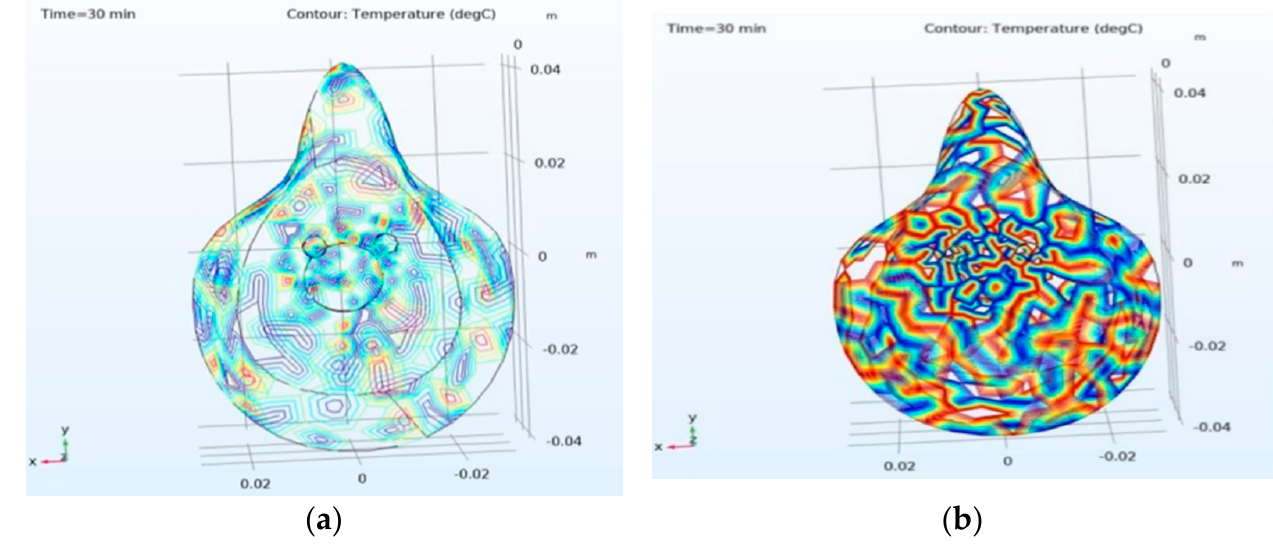
Figure 4. Temperature profile of the mask: ( a ) Inner layer at 20 °C; ( b ) outer layer at 70 °C. Equation (1) found in [19,20], the total atmospheric pressure, water vapor pressure, and room temperature pressure variation are denoted as P, p, and (P − p), respectively. At room temperature, the (P − p) value is nearly equal to P ~10 5 Pa. As per the mathematical calculation, the moisture concentration in the air is the function of (0.62 × 10 5 P)/~10 5 . By (0.018 P)/(0.029 (P − p)) = ((0.62 p))/((P − p))) (1)